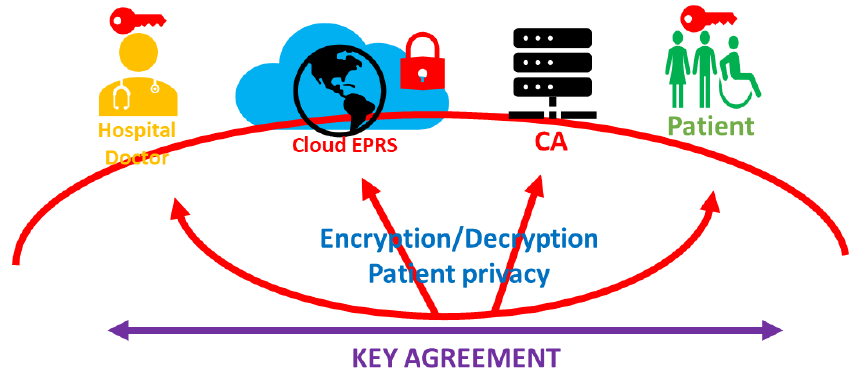
Figure 2. Our proposed iPatient privacy copyright cloud management system.